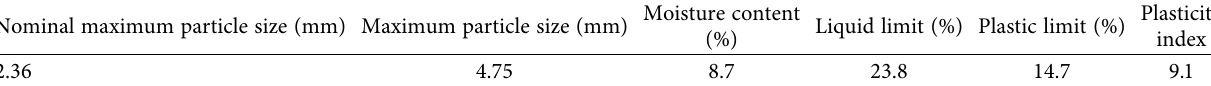
Table 1: Technical indexes of fine-grained soil.